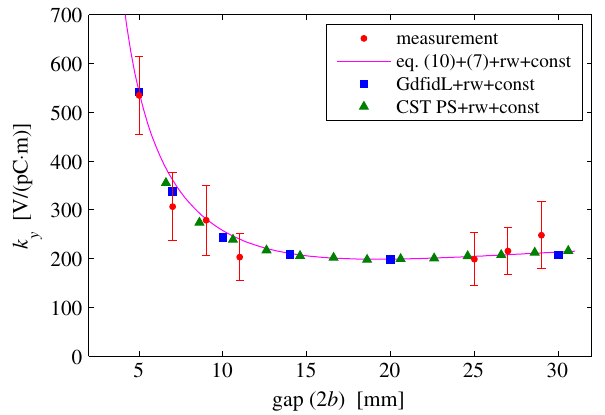
FIG. 12. Vertical kick factor vs ID